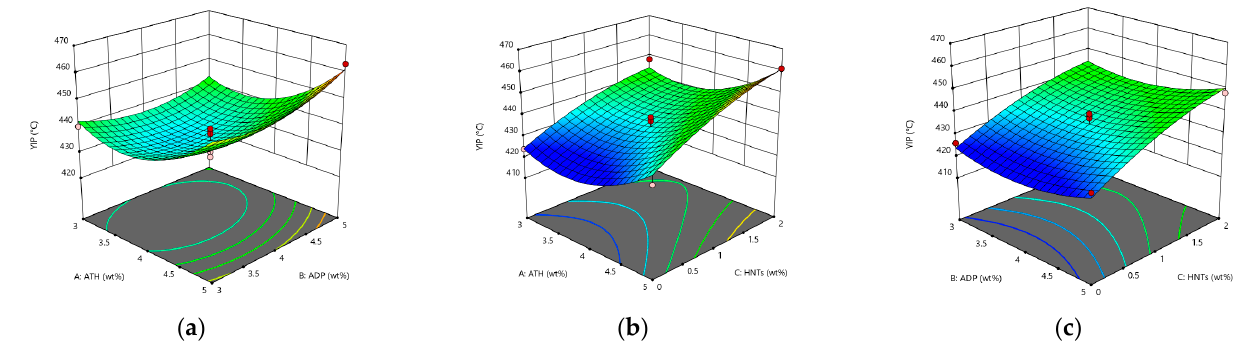
Figure 5. The response surface diagram of the flame retardant system to the change of ignition point: ( a ) Interactive effects of ATH and ADP; ( b ) Interactive effects of ATH and HNTs; and ( c ) Interactive effects of ADP and HNTs.